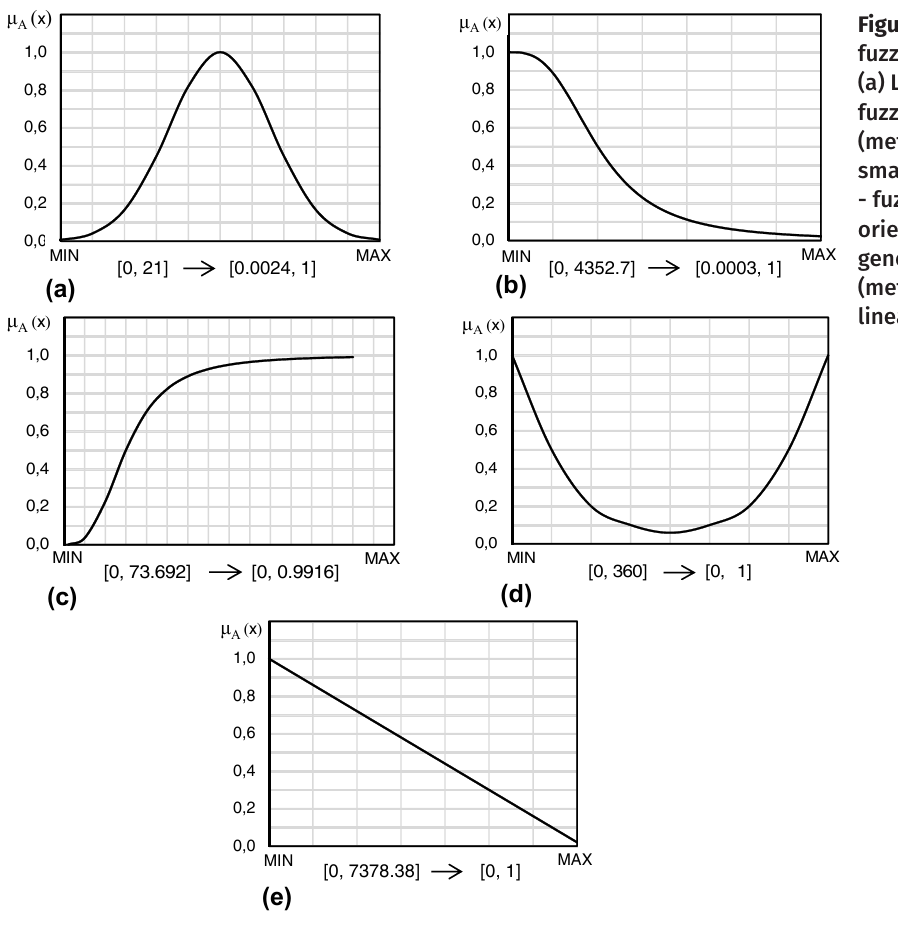
Figure 3. Diagrams of the fuzzy pertinence